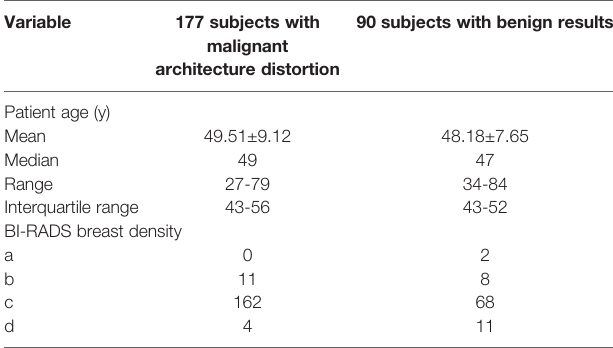
TABLE 1 | Characteristics of the population and digital mammographic examinations selected for the study.